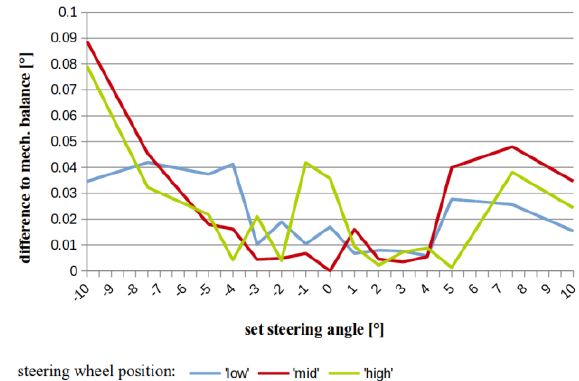
Figure 11. Histogram of the differences between the optical 2D shape-based and the mechanical measurement method